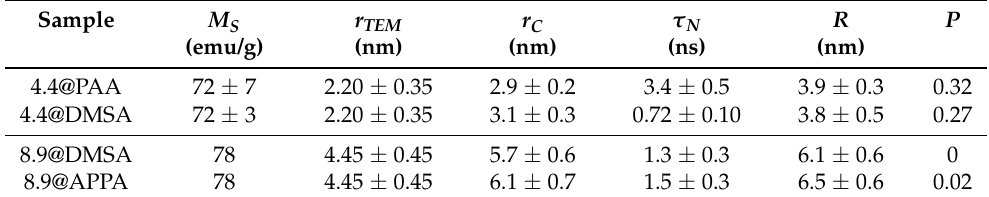
Table 3. Parameters obtained from the fit of the r 1 NMRD profiles. The Néel relaxation time τ N , the minimum approach distance R , and the parameter P were evaluated from the fit. (See the main text for more